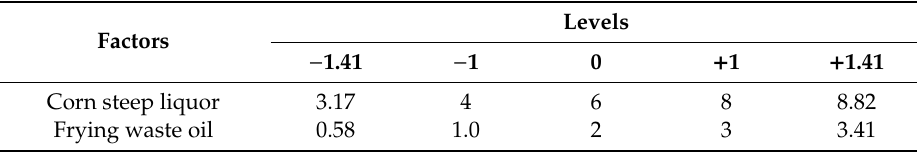
Table 1. Experimental data were analyzed using the response surface and contour curve of Statistica version 10 software (Statsoft Inc, Tulsa, OK, USA) and adjusted for a polynomial model. Table 1. Levels of experimental design of the central rotational composite design (RCCD 2 2